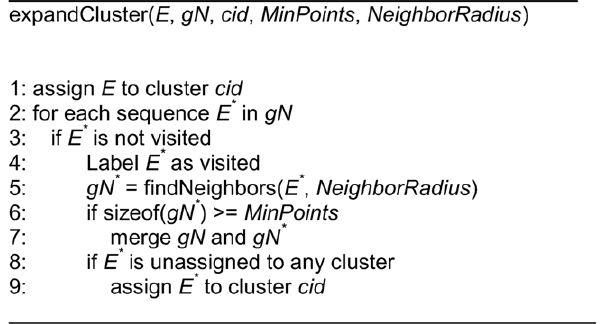
Figure 4. The pseudo codes for the expandCluster function.